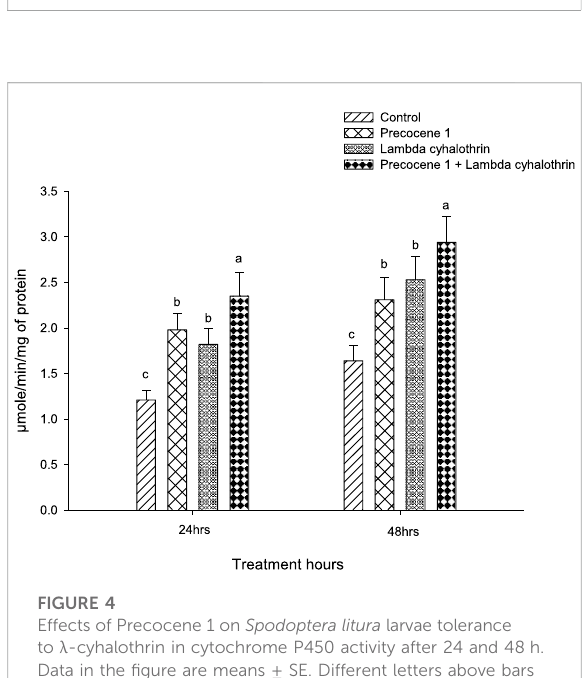
FIGURE 2 Effects of Precocene 1 on Spodoptera litura larvae tolerance to λ -cyhalothrin in β -esteraseactivityafter24and48 h.Datainthe fi gure are means ± SE. Different letters above bars indicate signi fi cant differences ( p < 0.05) according to the Tukey HSD test.